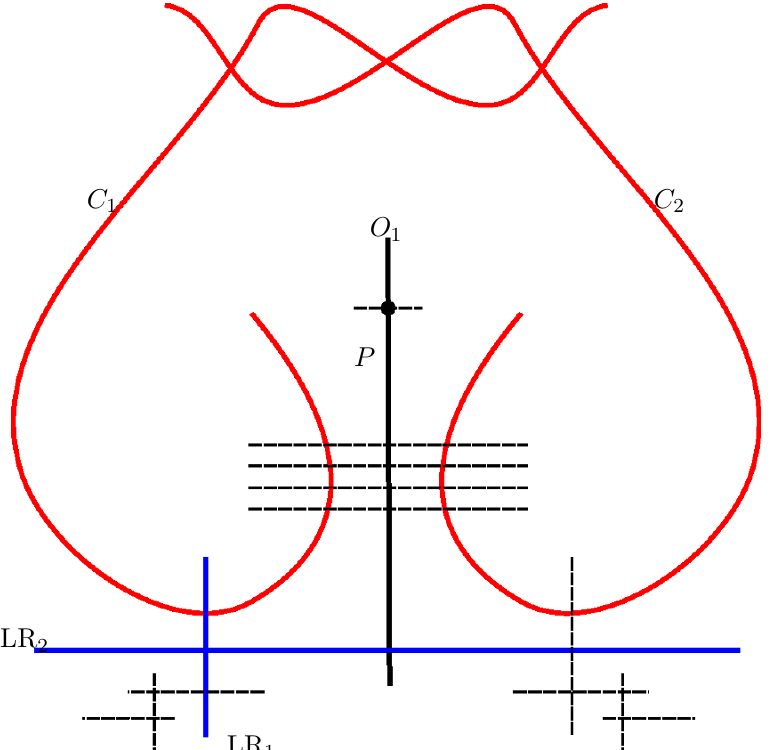
Figure 1 . Schematic structure of the resolved complex structure moduli space of X ∗ complex structure divisors are shown in blue and the conifold components are red. Exceptional divisors resolving non-normal crossing intersections are indicated with dashed